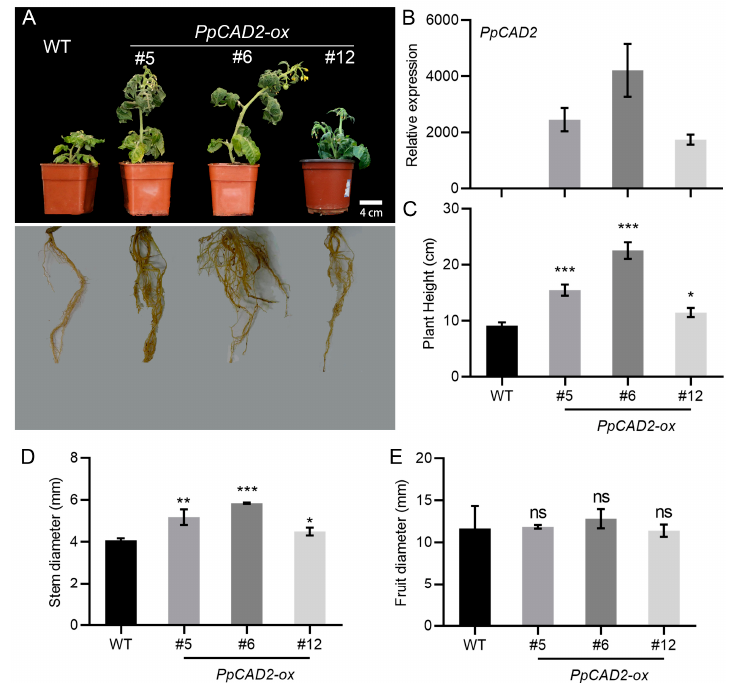
Figure 1. Phenotype analysis of non-transgenic (WT) and PpCAD2 -overexpressing ( PpCAD2-ox ) transgenic tomato lines. ( A ) Photographs of the morphology in the WT and transgenic lines; ( B ) The relative expression level of PpCAD2 in the WT and transgenic plants; ( C ) The plant height of the WT and transgenic plants; ( D ) The stem diameter the WT and transgenic plants; ( E ) The fruit diameter of the WT and transgenic plants. In all cases, the data represent the mean ± SD (standard deviation) from three biological replicates. Significant differences between the wild-type and transgenic plants are indicated (* P < 0.05, ** P < 0.01, *** P < 0.001, Student’s t-test ).